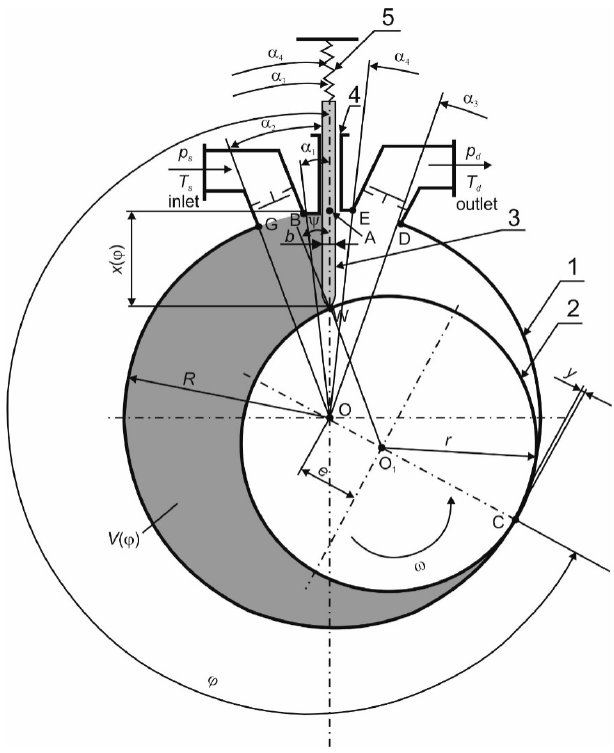
Figure 2. The simplified scheme of the rolling piston expander.